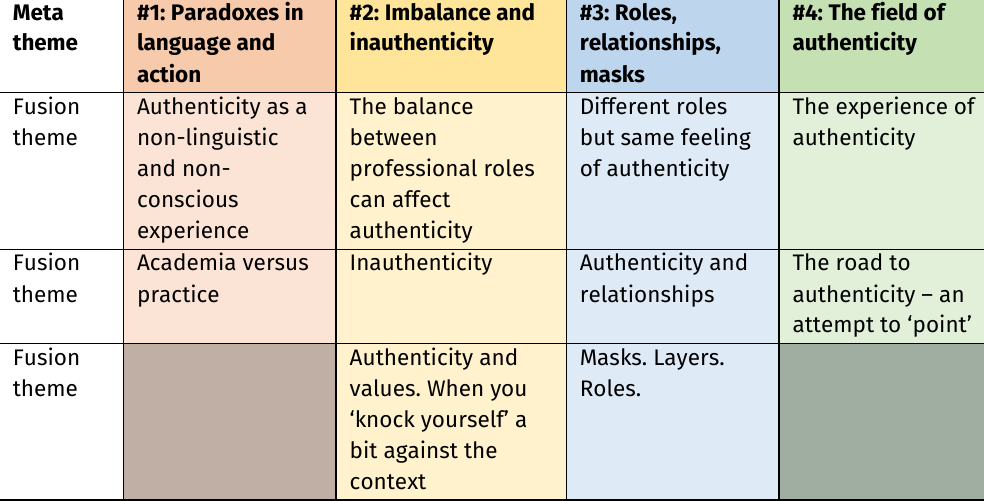
Figure 1.1. Meta Themes and Fusion